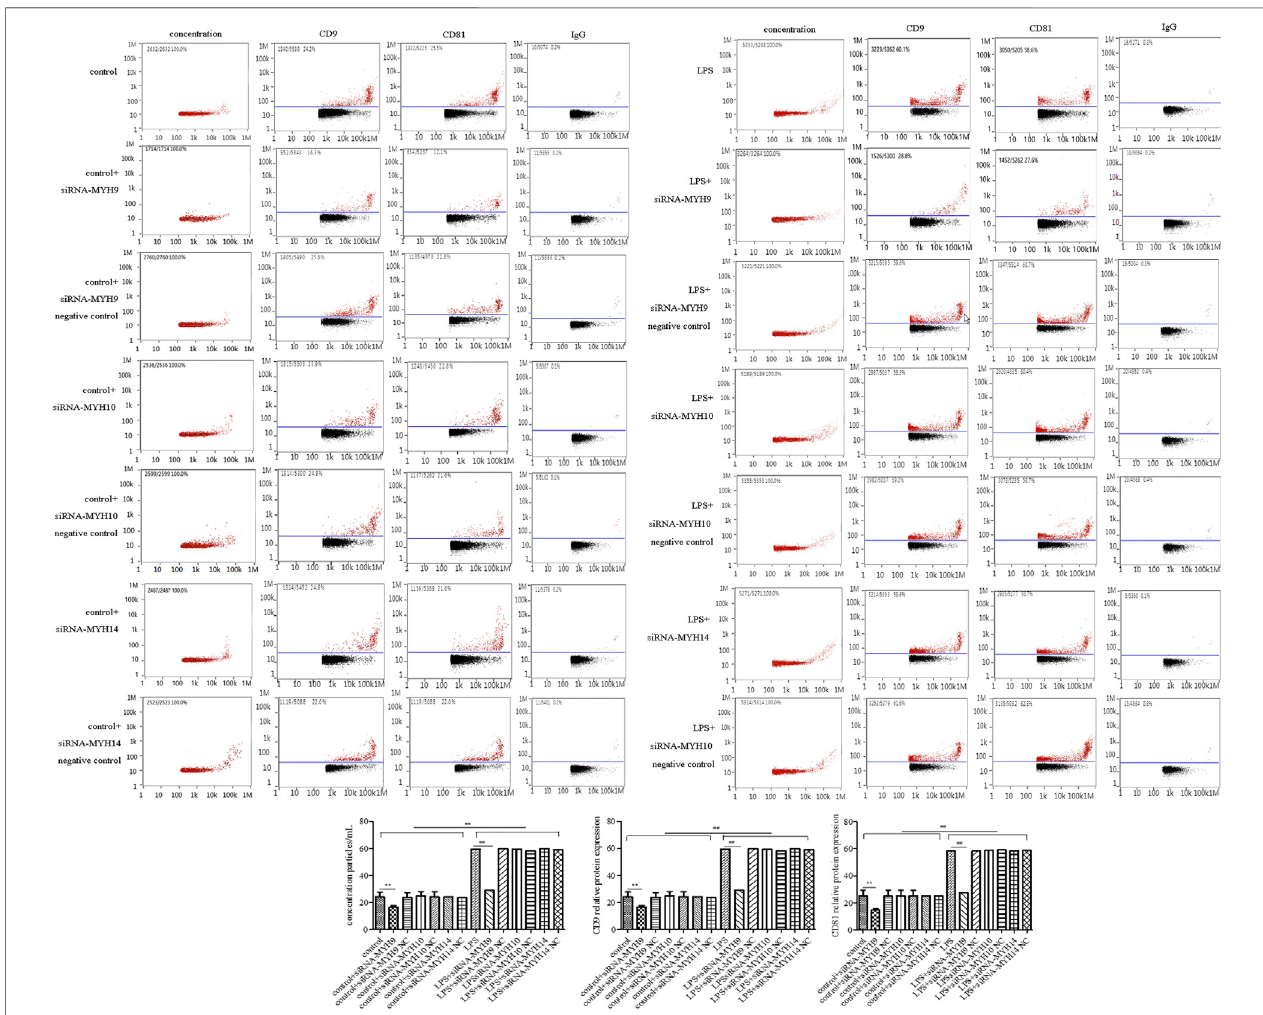
FIGURE 4 | Transfection of siRNA-MYH9, but not siRNA-MYH10 or siRNA-MYH14 inhibited exosome release from microglial cells stimulated by LPS. For transfection,microglialcellsweresub-culturedin24-wellplatesatadensityof3 × 10 5 cells/ml.TheextractedexosomesweregroupedbasedontransfectionwithsiRNA or siRNA into microglial cells. Whether control or LPS stimulation cells were transfected with siRNA-MYH9, siRNA-MYH10, or siRNA-MYH14 at a fi nal concentration of 100 nM for 48 h. Microglial cells stimulated by 1 mg/ml LPS for 24 h, microglial cells transfected with siRNA followed by 24 h LPS stimulation, microglial cells transfected with siRNA negative control followed by 24 h LPS stimulation. (A) Nanoparticle tracking analysis for the concentration of exosomes. (B) Flow cytometry analysis for CD9-labeled positive rate, CD81-labeled positive rate, or control FITC-IgG-labeled positive rate. Nine independent experiments were analyzed. A histogram depictedthequantitativerepresentations oftheprotein expression levelsofCD9andCD81foreach group.ThedatawereaverageswithSD, n (cid:2) 9. ** p < 0.01vs. control microglial cells; ## p < 0.01 vs. microglial cells stimulated with LPS.